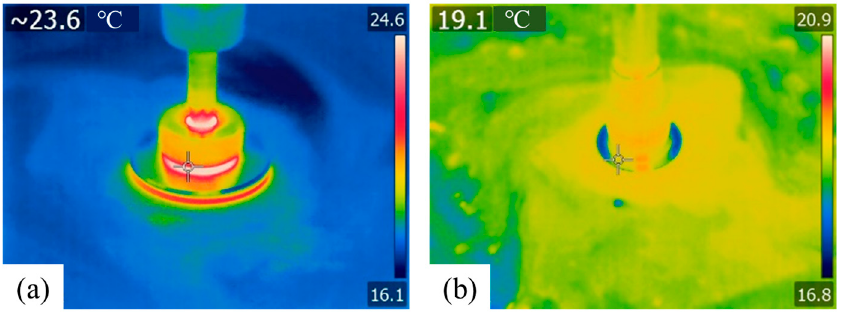
Figure 11. Thermal imaging of machining with different liquid supply methods. ( a ) External liquid supply; ( b ) internal liquid supply.